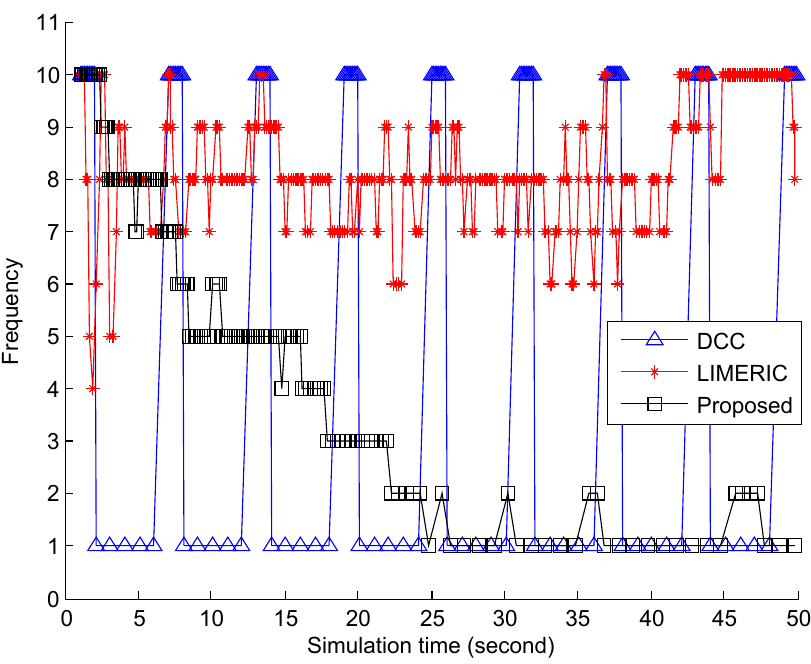
Figure 4. Comparison of beacon frequency of the three congestion control